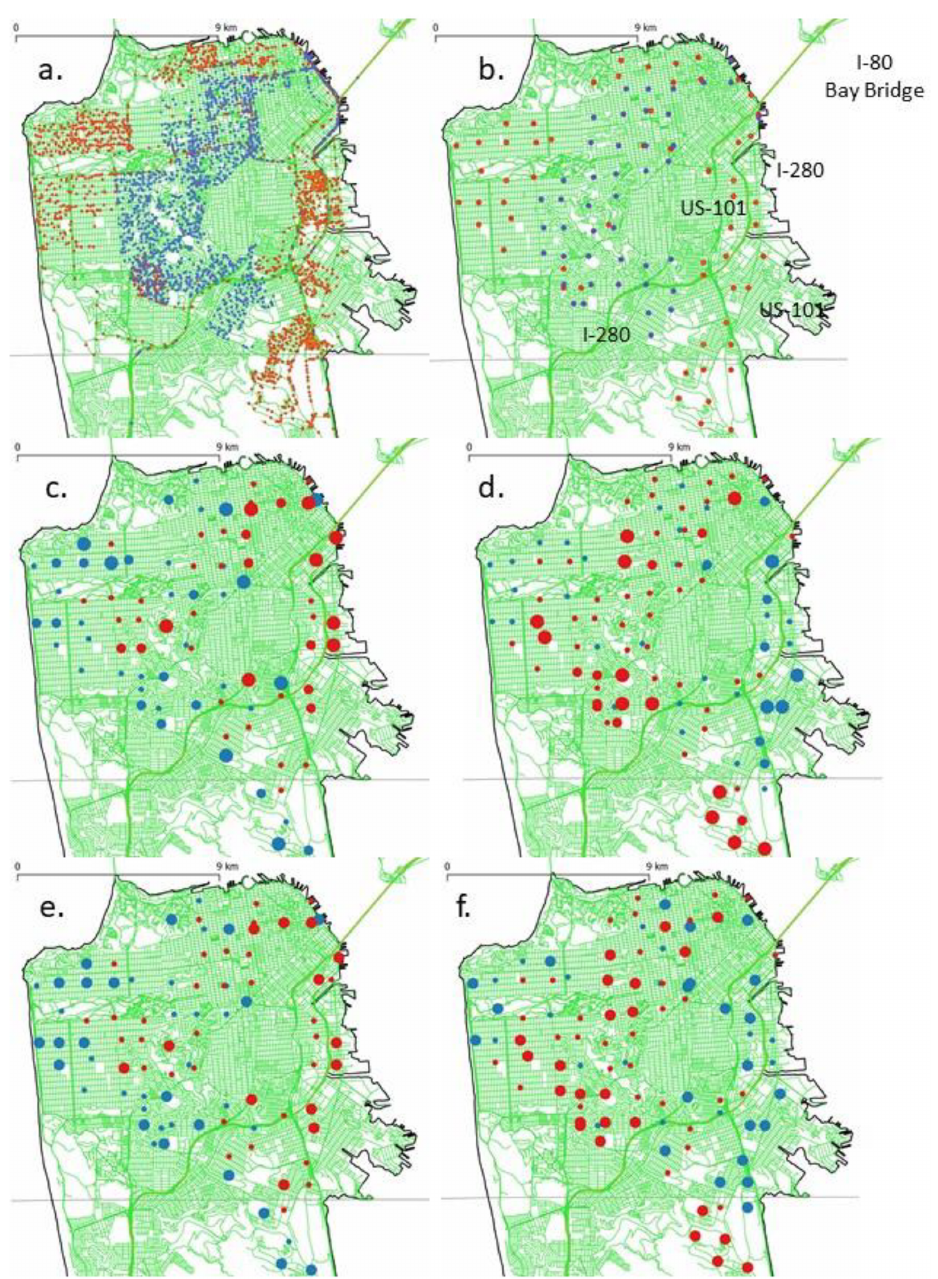
Figure 7. San Francisco sampling locations and results for 1–12 May 2017: (a) 1min resolution locations (gold is Flora, lavender is Coltrane), (b) 1km resolution locations (gold is Flora, lavender is Coltrane), (c) NO 2 intervehicle differences (red is positive, blue is negative; large symbol = < − 4 or >4ppbv, medium = − 4 to − 2 or 2 to 4ppbv, small = − 2 to + 2ppbv), (d) O 3 intervehicle differences (same scale as NO 2 ), (e) NO 2 FMD (red is positive, blue is negative; large symbol = < − 0 . 5 or >0.5, small = − 0 . 5 to + 0 . 5), (f) O 3 FMD (red is positive, blue is negative; large = < − 0 . 05 or >0.05, small = − 0 . 05 to + 0 . 05). Maps generated with QGIS version 3.2.2